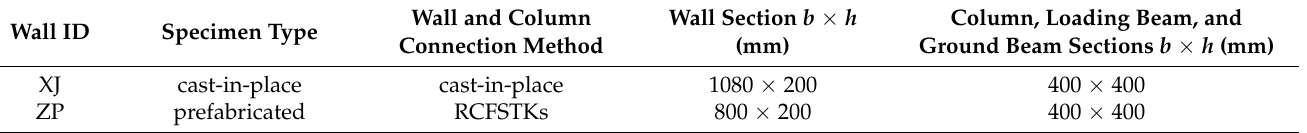
Table 1. Design parameters of specimens.